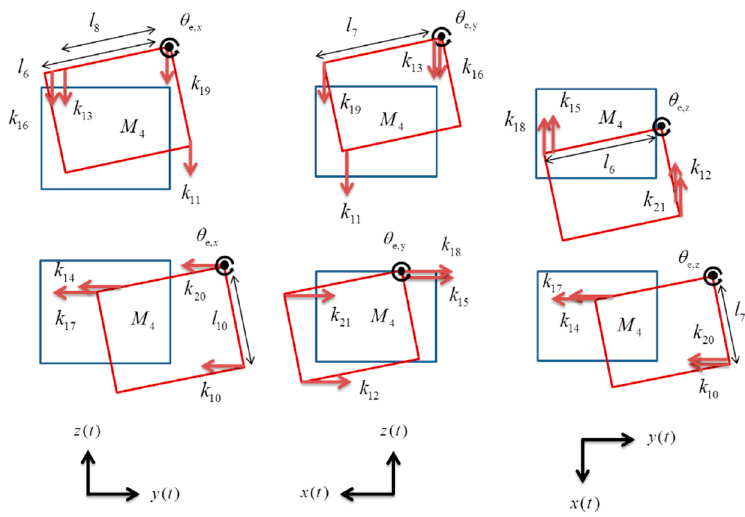
6 of 17 Figure 4. Free-body diagrams of the bracket unit. The equations of motion for bracket unit 𝑀 (cid:2871) are as follows: 𝑀 (cid:2871) 𝑧(cid:4663) (cid:2871) + 𝑘 (cid:2870) (𝑧 (cid:2871) − 𝑧 (cid:2869) − 𝑙 (cid:2872) 𝜃 (cid:3031),(cid:3051) ) + 𝑘 (cid:2869)(cid:2871) (𝑧 (cid:2871) − 𝑧 (cid:2872) ) = 0 (14) 𝑀 (cid:2871) 𝑦(cid:4663) (cid:2871) + 𝑘 (cid:2869) (𝑦 (cid:2871) − 𝑦 (cid:2869) + 𝑙 (cid:2872) 𝜃 (cid:3031),(cid:3051) ) + 𝑘 (cid:2869)(cid:2872) (𝑦 (cid:2871) − 𝑦 (cid:2872) ) = 0 (15) 𝑀 (cid:2871) 𝑥(cid:4663) (cid:2871) + 𝑘 (cid:2869)(cid:2873) (𝑥 (cid:2871) − 𝑥 (cid:2872) ) + 𝑘 (cid:2875) (𝑥 (cid:2871) − 𝑥 (cid:2869) − 𝑙 (cid:2873) 𝜃 (cid:3031),(cid:3052) ) = 0